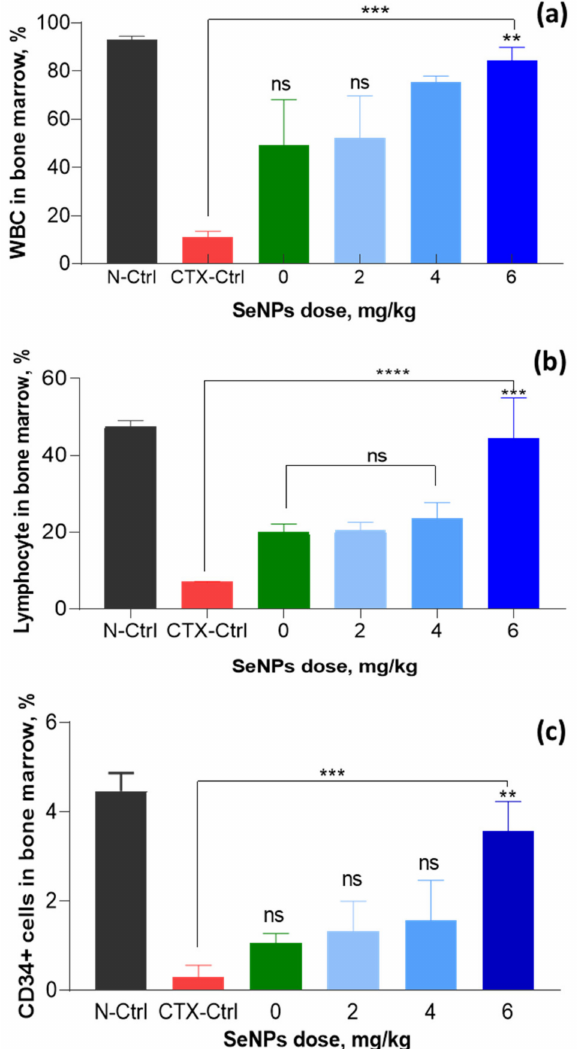
Figure 13. Effect of SeNPs/ β -glucan concentration on cellular immunity indexes in bone marrow